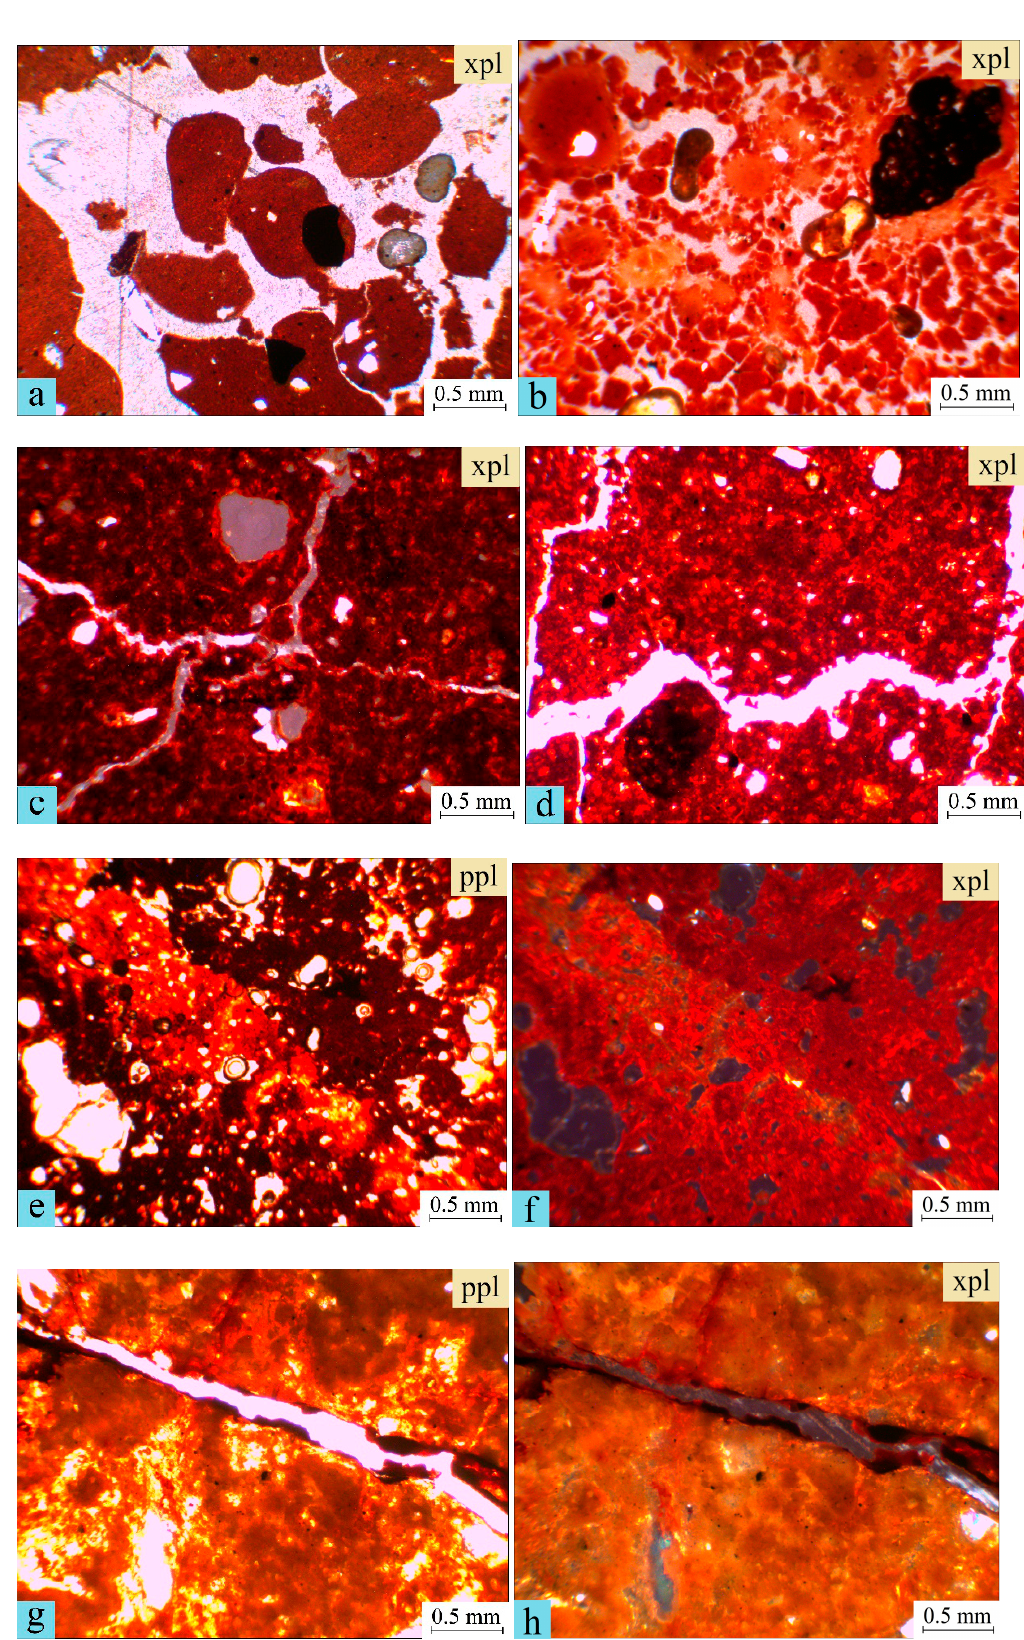
Figure 3. Soil microstructure patterns: ( a ) overlying Oxisol, A horizon; ( b ) Oxisol, B horizon; ( c – f ) red-yellow matrix; ( g , h ) white-yellow matrix. Note residual Mn oxide deposits along planar void in ( g , h ). ppl: plane polarized light; xpl—cross-polarized light.